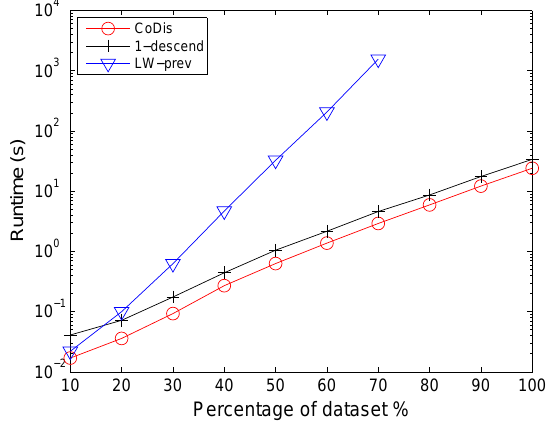
Figure 7. Impact of the structure size on the